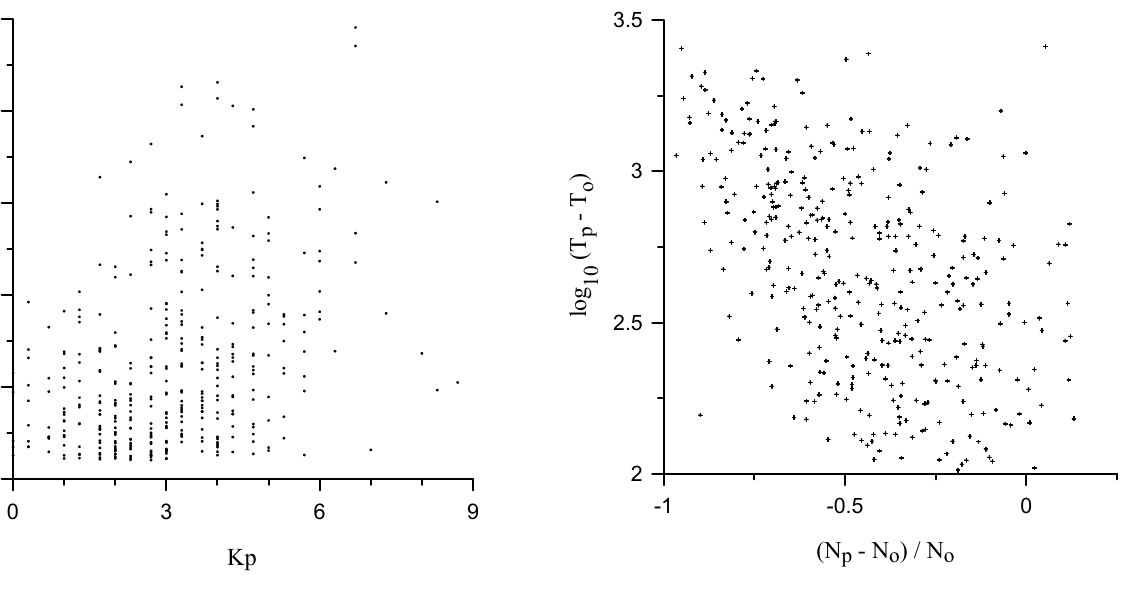
Fig. 8. The relationship between the measured electron tempera- ture changes at 400km during NETEs over Millstone Hill and a 3-h geomagnetic activity index K p . The temperature changes are ex- pressed as the difference between the temperature at the peak, T p , and the temperature at the onset, T o .